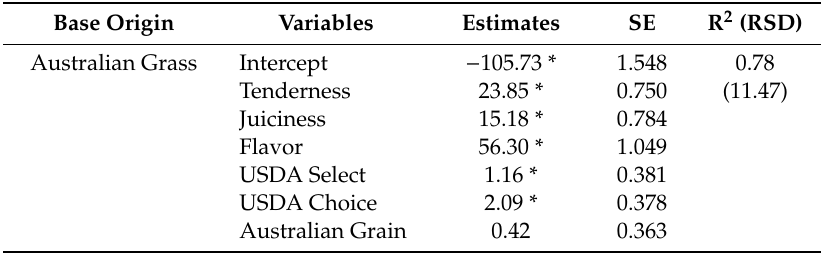
Table 3. Fixed e ff ects model for origin impact on consumer